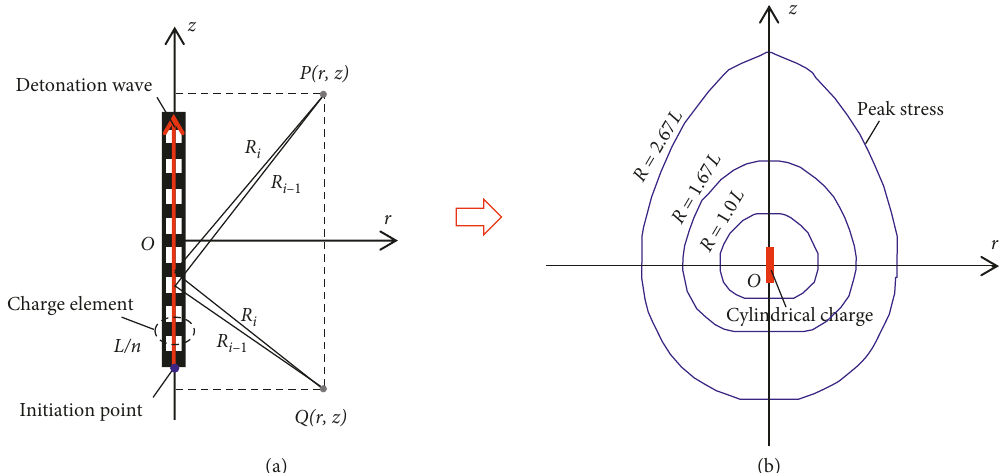
Figure 4: Illustration of the phase delay effect of the charge elements. (a) Computation model of the blast stress field of cylindrical charge. (b) Normalized peak stress at the same distance from the charge center O , and the peak stress is represented by the normalized distance from O in the polar coordinate